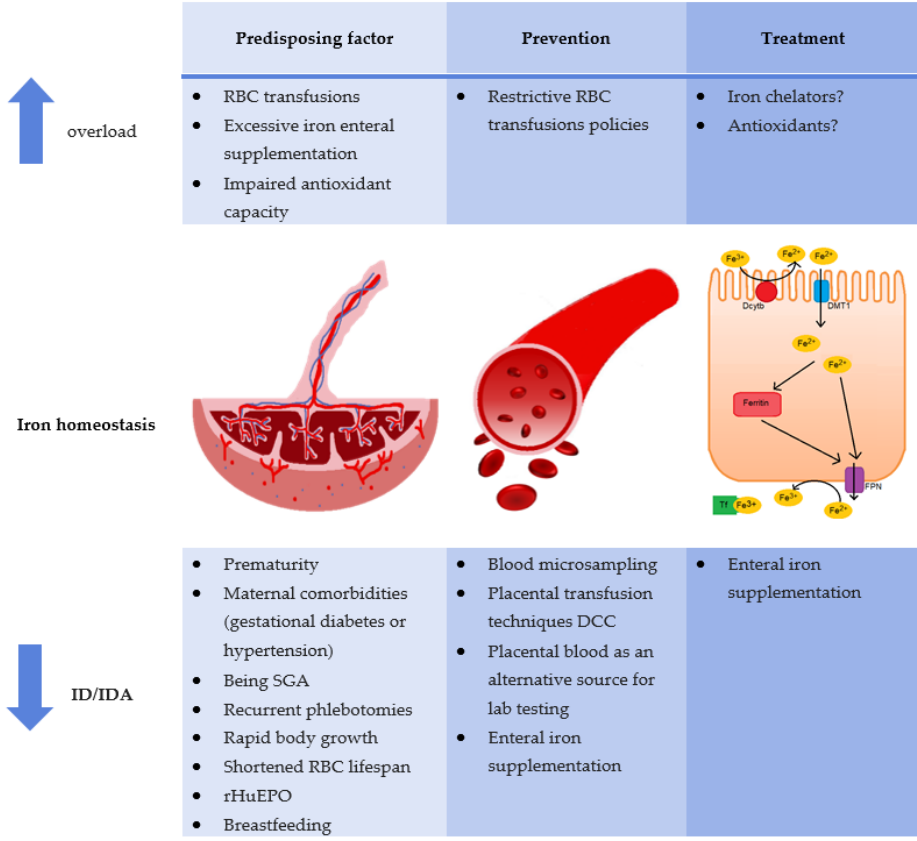
Figure 2. Iron homeostasis in preterm newborns: risk factors, prevention strategies and treatment. DCC: delayed cord clamping; Dcytb: duodenal cytochrome b; DMT1: divalent metal transporter; Fe 2+ : ferrous cation; Fe 3+ : ferric cation; FPN: ferroportin; RBC: red blood cell; rHuEPO: recombinant human erythropoietin; SGA: small for gestational age; TF: transferrin.